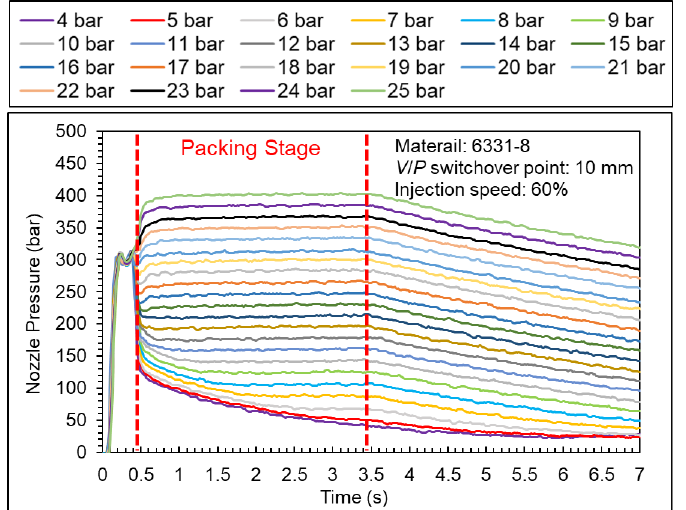
Figure A4. Nozzle pressure profiles of 6331 − 8 at different packing pressures.